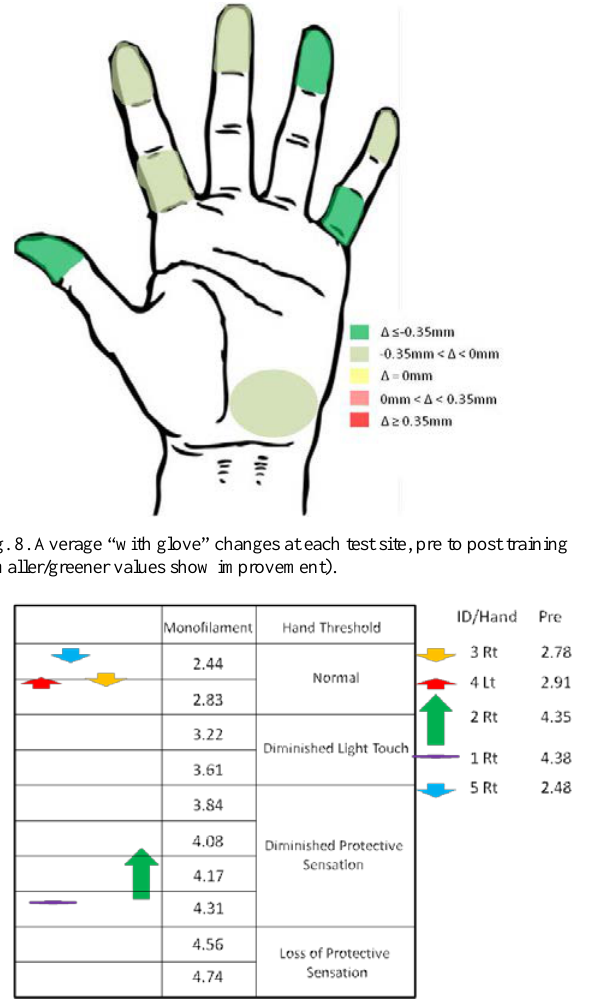
Fig. 9. Without glove average changes for each of the five hands, illustrated on a sensation threshold scale.